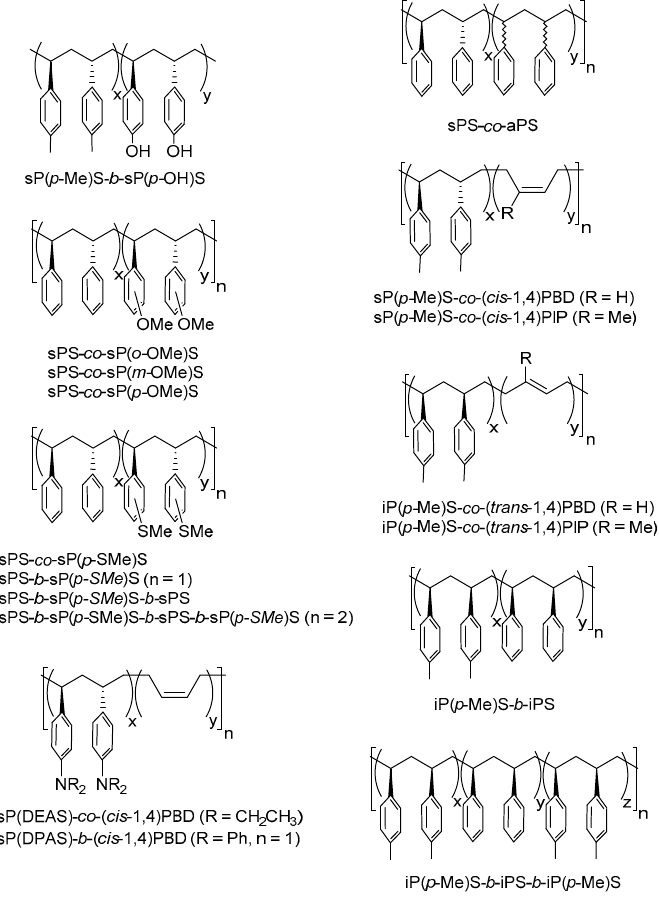
Figure 5. Structure of stereoregular styrene derivative copolymers.